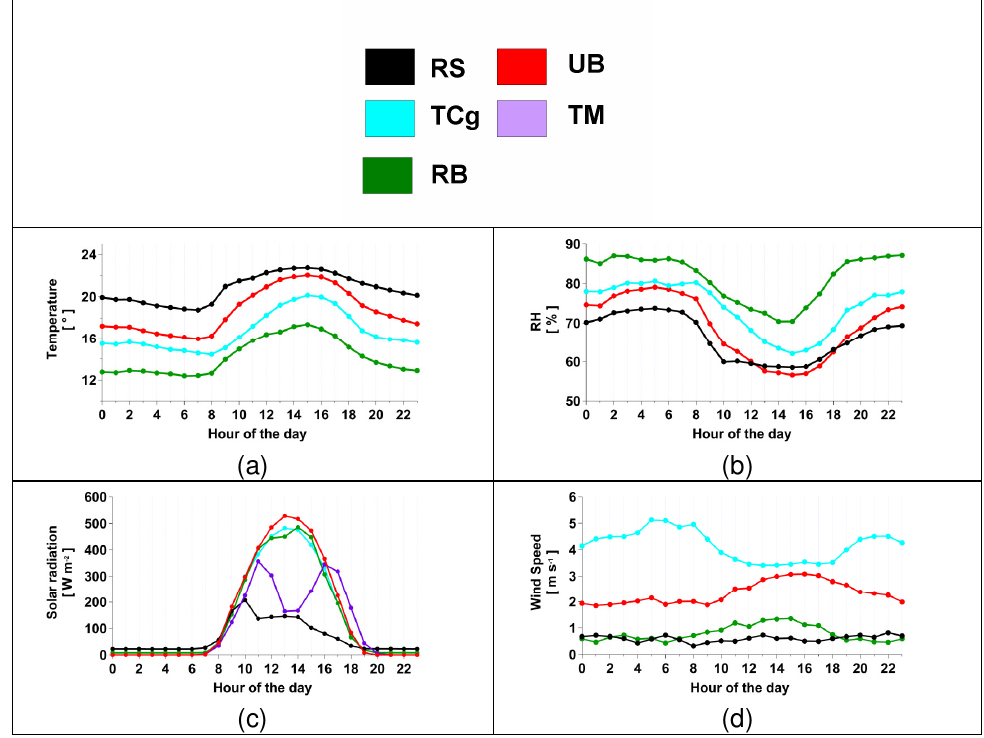
Fig. 6. Diurnal average temperature (a) , RH (b) , solar radiation (c) and wind speed (d) at five different SAPUSS monitoring sites.